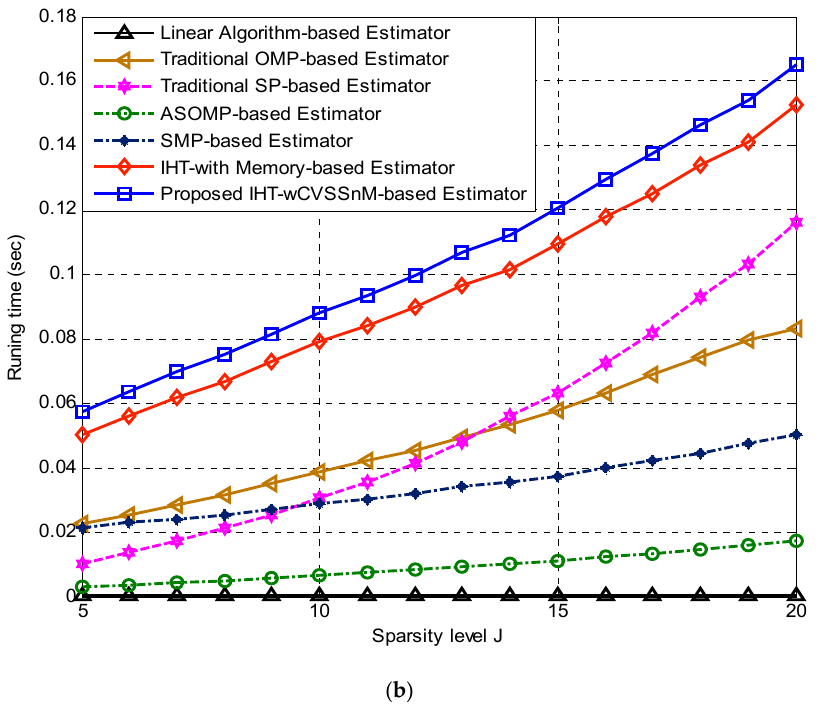
Figure 4. CPU running time versus temporal correlation degree of dynamic sparse channel comparison for all the channel estimators ( a ) SNR = 5 dB, ( b ) SNR = 15 dB.